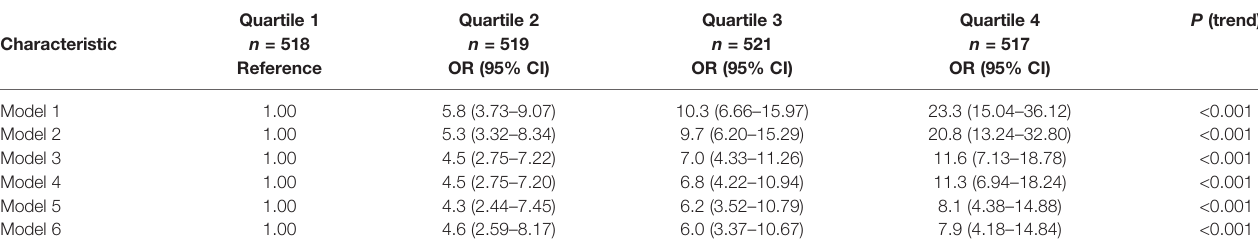
TABLE 4 | Association between RBP4 and hyperuricemia according to logistic regression.